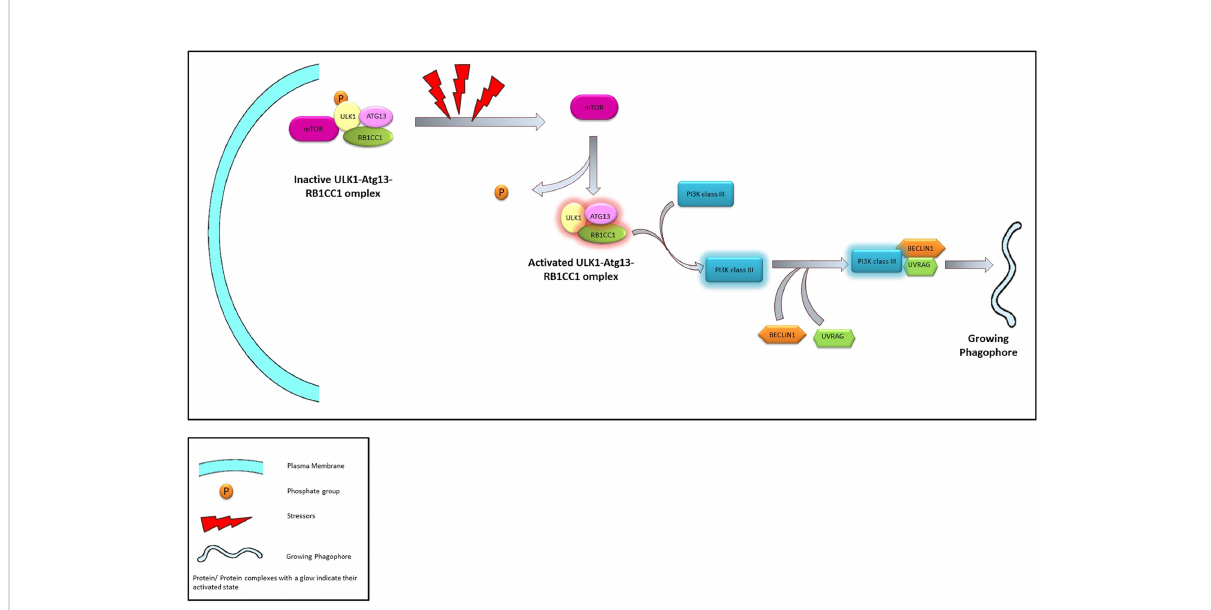
FIGURE 3 The Process of Nucleation. Under normal conditions ULK1-Atg13-RB1CC1 is maintained in an inactivated state through phosphorylation promoted by interaction with mTOR. In presence of stressors ULK1-Atg13-RB1CC1 complex is activated following dissociation from mTOR and dephosphorylation. ULK1 complex activates class III PI3K which in turn associates with Beclin1 and UVRAG leading to the initiation of